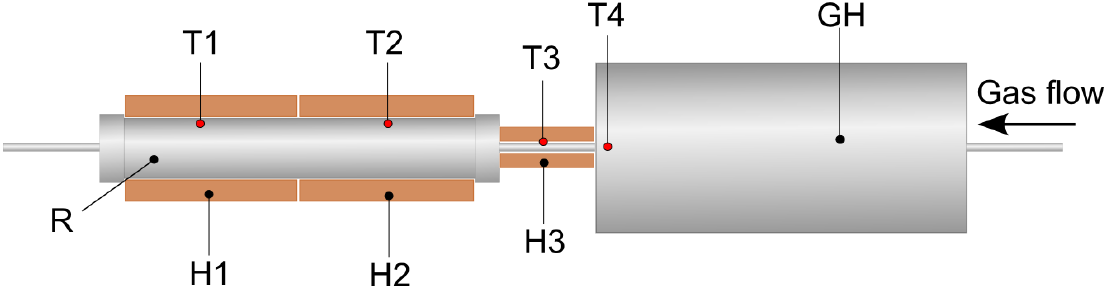
Figure 3. Bench scale reactor setup used in torrefaction experiments (R–reactor; GH–gas heater; H1, H2, H3–heaters; T1, T2, T3, T4–thermocouples; all thermocouples were